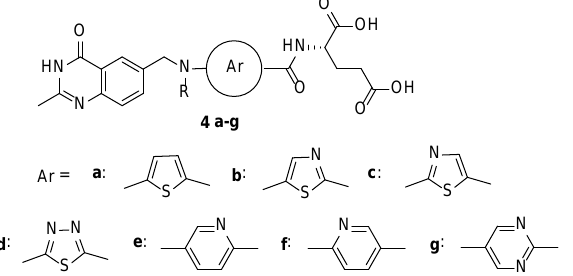
Scheme 14. Structures of a series of C2-methyl-N10-alkylquinazoline-based antifolates. Reproduced with the permission of reference [33]. Copyright © 1991, American Chemical Society.